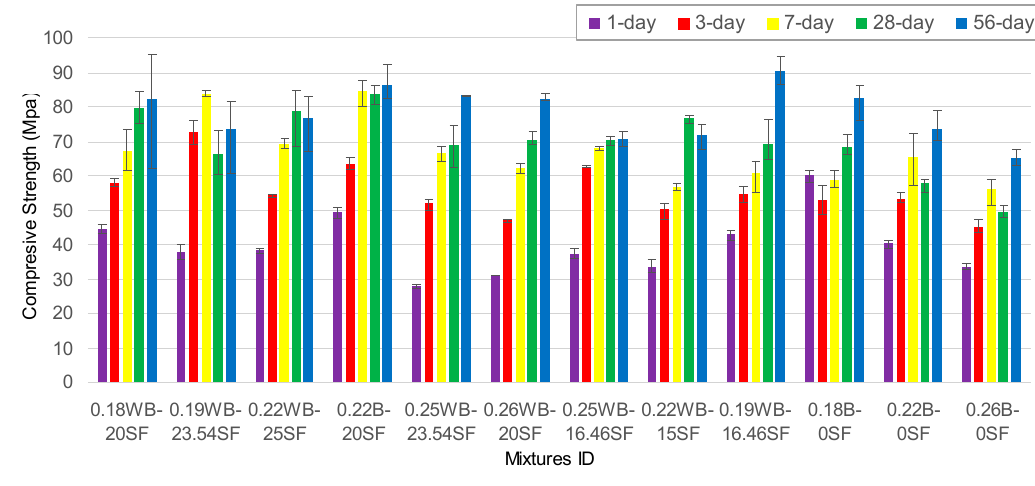
Figure 6. Compressive strength of RPC mixtures.